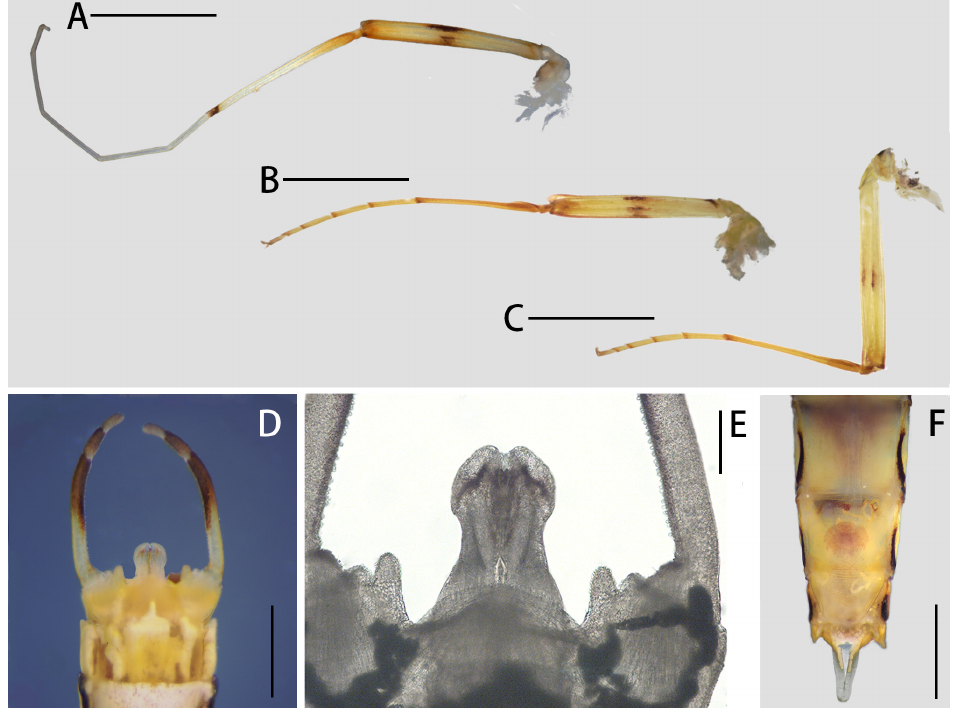
Figure 7. Adult structures of Regulaneuria cingulata : ( A ) Foreleg of male; ( B ) Midleg of male; ( C ) Hindleg of male; ( D ) Genitalia; ( E ) Penes enlarged (ventral view); ( F ) Subgenital and subanal plates of female (ventral view). Scale bars: ( A – C ) = 2.0 mm; ( D ) = 0.5 mm; ( E ) = 0.2 mm; ( F ) = 2.0 mm.